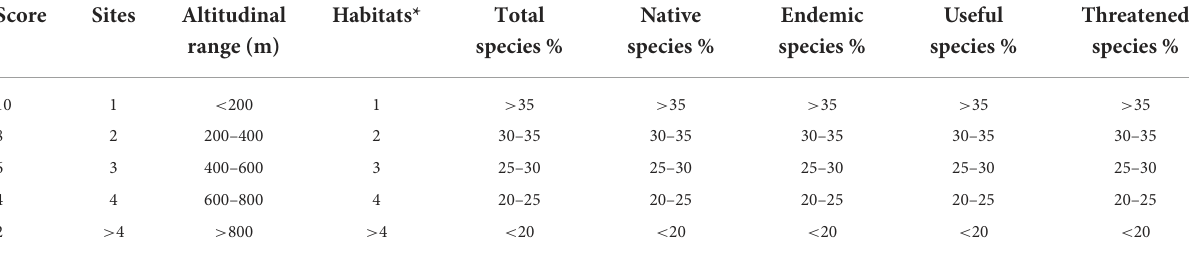
TABLE 2 Attributes used to calculate the CPI of communities and habitats.